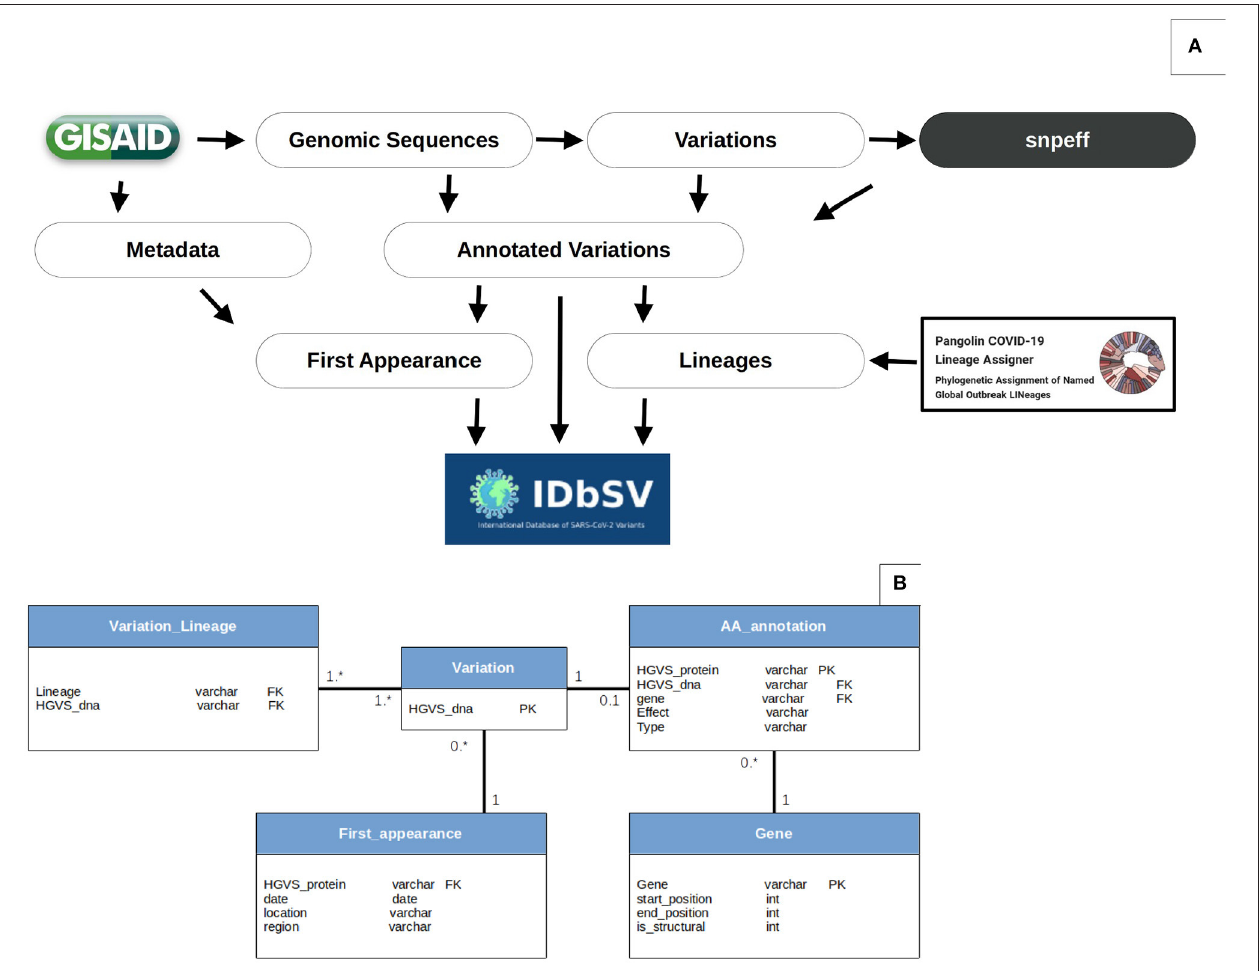
FIGURE 1 | Data analysis workflow and database schema. (A) Variations’ extraction workflow: the flowchart resumes the procedure of variation extraction and annotation. The variations are identified using MINIMAP2, SAMTOOLS and BCFTOOLS and annotated using snpEff. These SNPs are then associated with appropriate strain’s metadata and lineages according to GISAID (www.epicov.org/epi3/) and PANGOLIN (pangolin.cog-uk.io). The data is then exported from CSV files to relational tables as SQL files. Finally, the outputs are deployed online on a monthly basis. Data processing scripts are available openly in https://github.com/ mouneem/IDbSV and the extracted list of strains can be found in Supplementary Table 1 . (B) Database Schema. Using this object-oriented architecture, instead of the standard VCF table, allowed further queries and alleviation of search queries flexibility and reduced